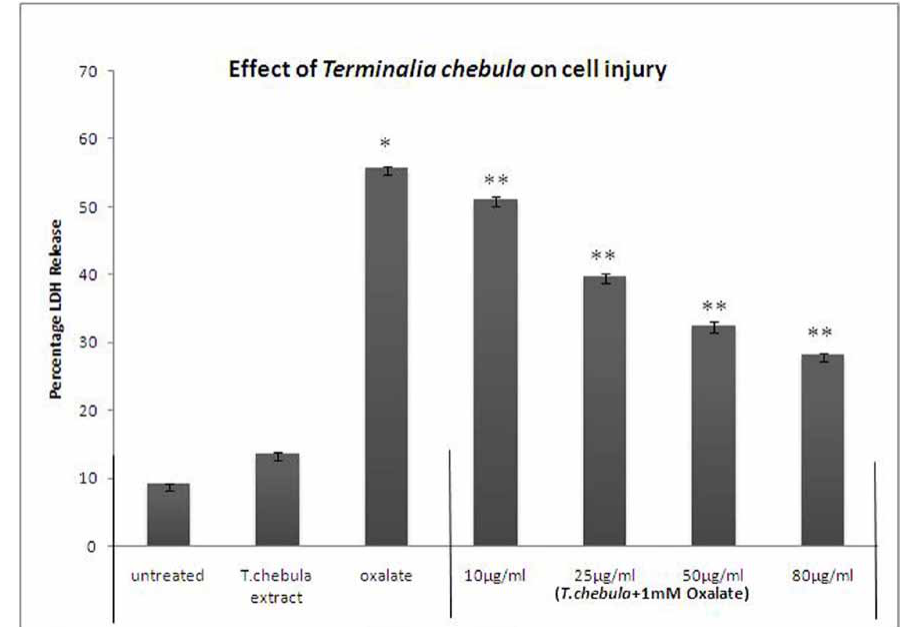
Figure 6 – Effect of Terminalia chebula on the % LDH release of NRK-52E. Data are mean ± S.D. of three independent observations. * p < 0.05 versus untreated control, ** p < 0.05 versus oxalate